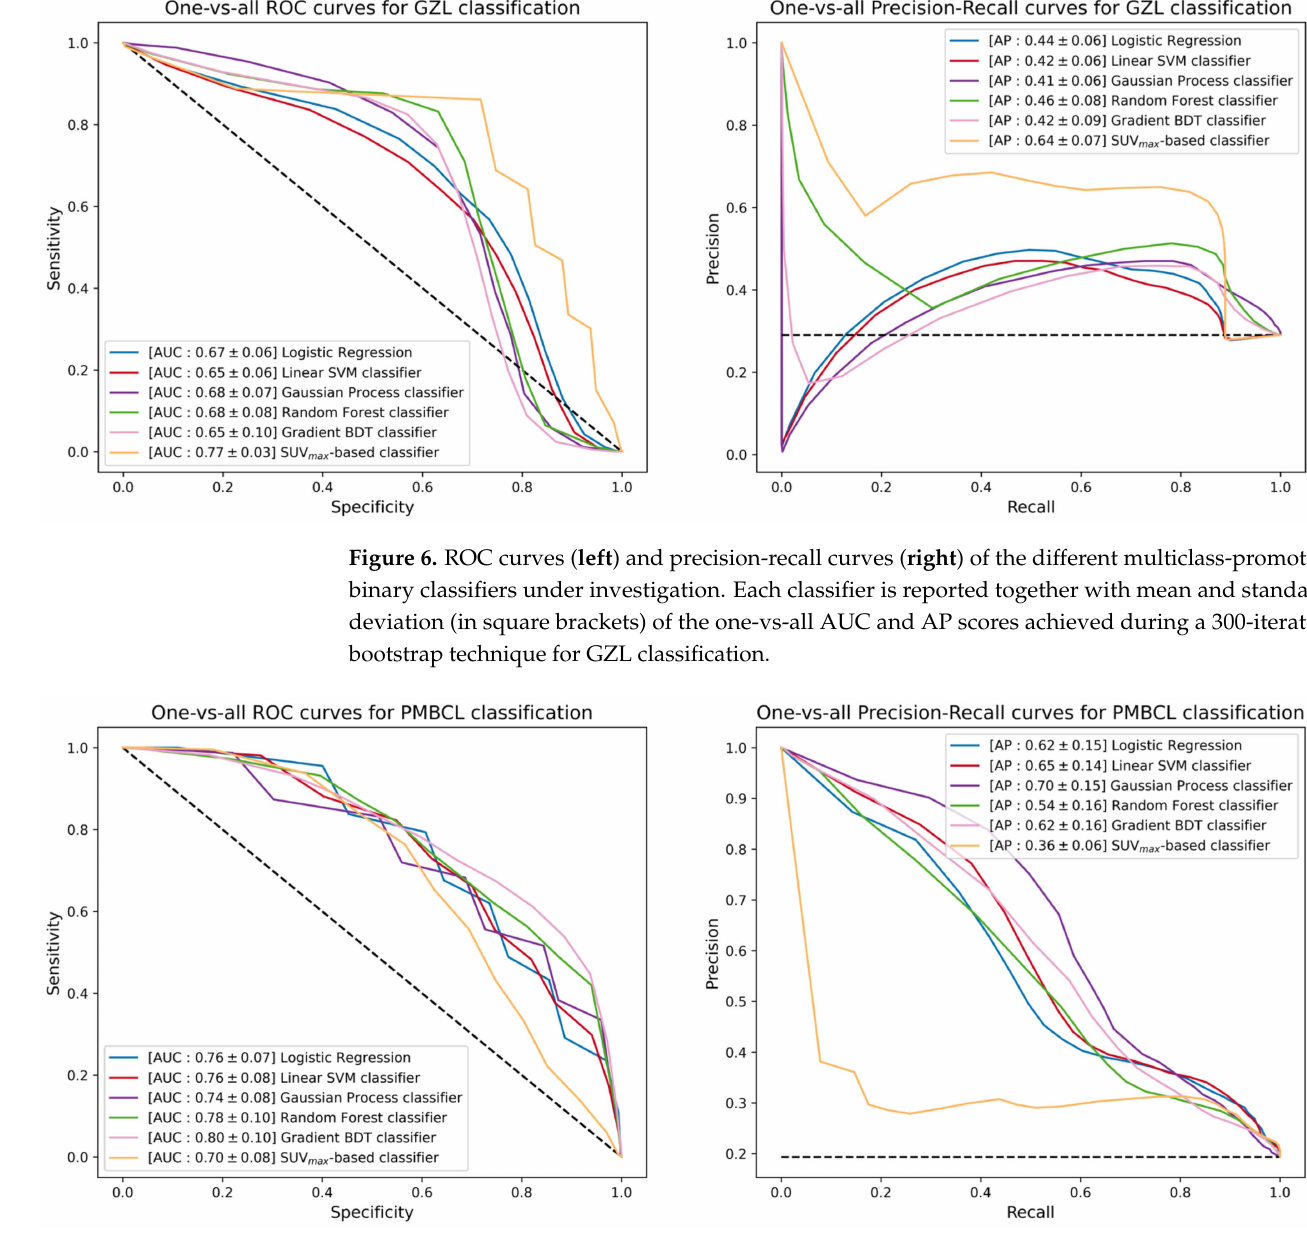
Figure 7. ROC curves ( left ) and precision-recall curves ( right ) of the different multiclass-promoted binary classifiers under investigation. Each classifier is reported together with mean and standard deviation (in square brackets) of the one-vs-all AUC and AP scores achieved during a 300-iterated bootstrap technique for PMBCL